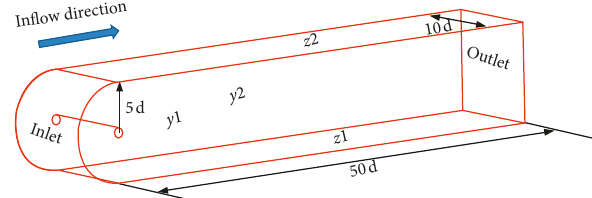
Figure 1: Computation domain for the cylindrical turbulent